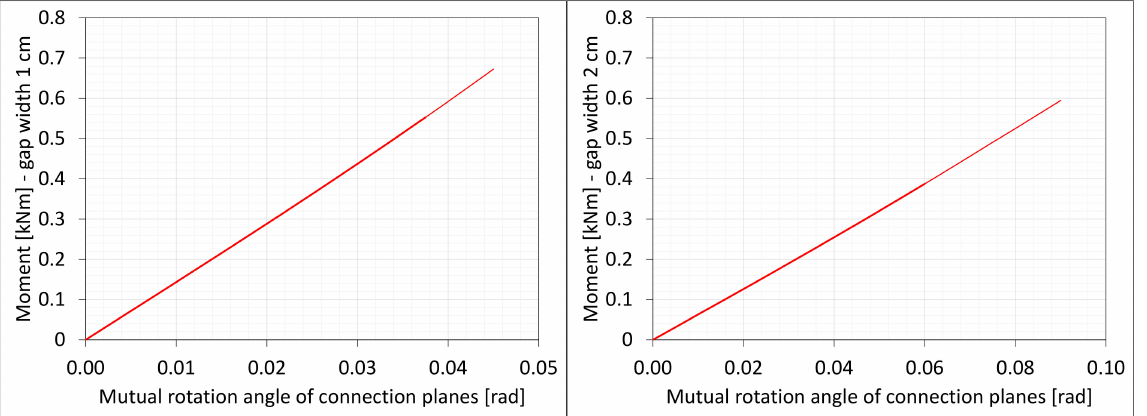
Figure 10. Equilibrium paths for excitation moment M z . The gap width is equal to 1.0 cm, left graphic, and 2.0 cm, right graphic. Parts of charts with non-physical deformations are displayed with thin lines.